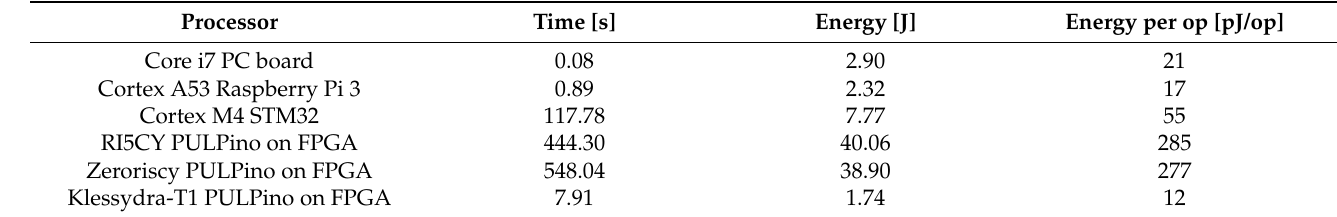
Table 5. Performance comparison with alternative